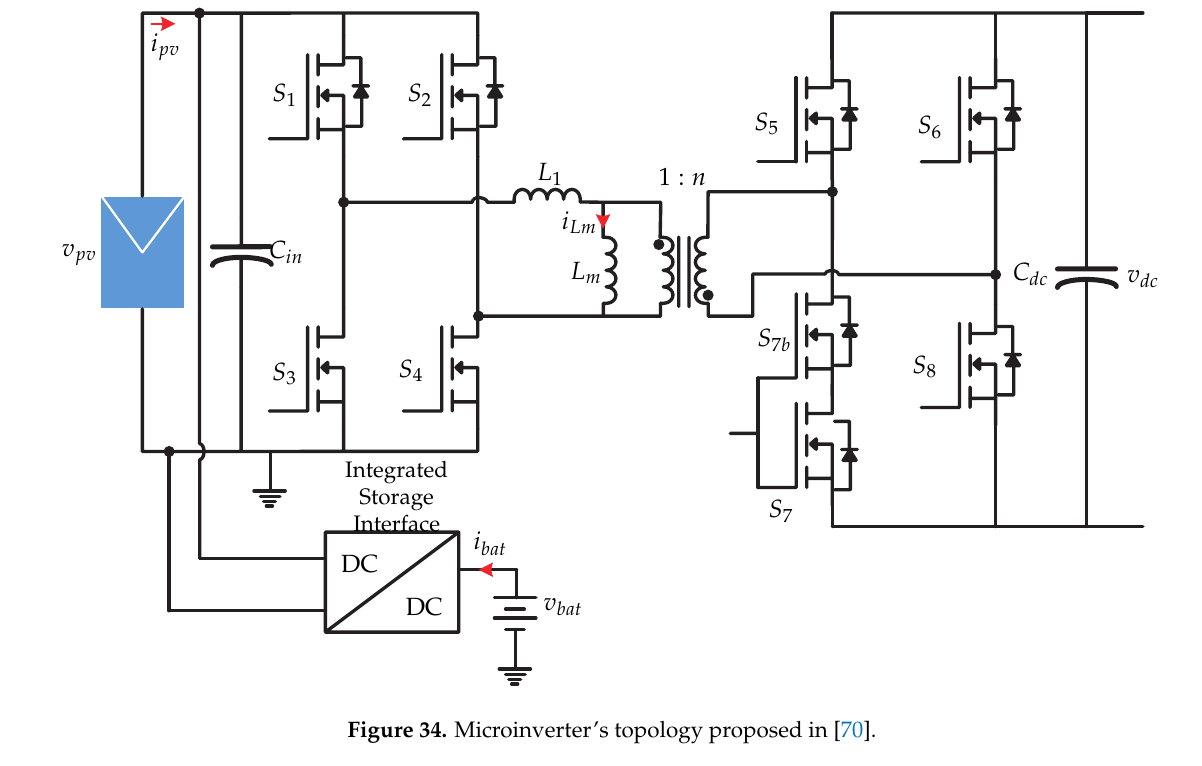
Figure 34. Microinverter’s topology proposed in [70].